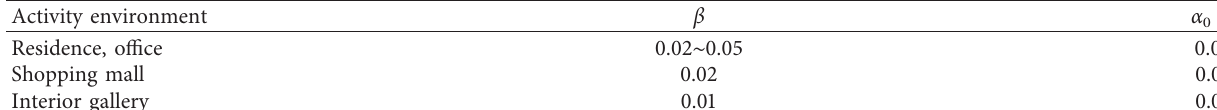
Table 2: Vertical vibration acceleration limit of floor in ATC.